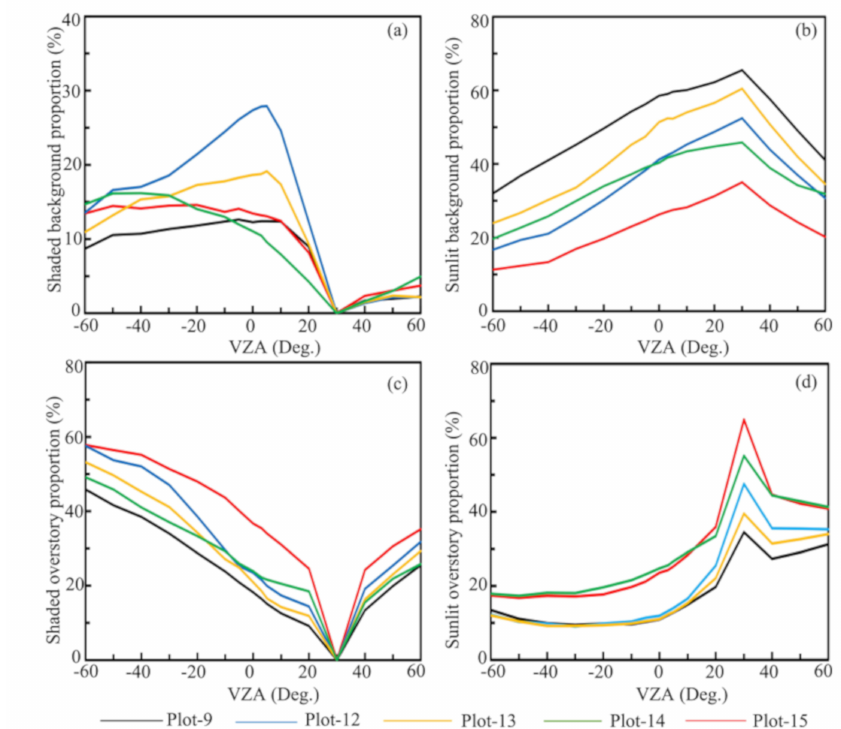
Figure 14. The spatial variations of the four forest component proportions including shaded forest background (inset a ), sunlit forest background (inset b ), shaded overstory (inset c ), and sunlit overstory (inset d ) with the view zenith angles changing from –60 ◦ to 60 ◦ in the solar principal plane with the solar zenith angle of 30 ◦ for five forest plots with di ff erent tree heights or crown